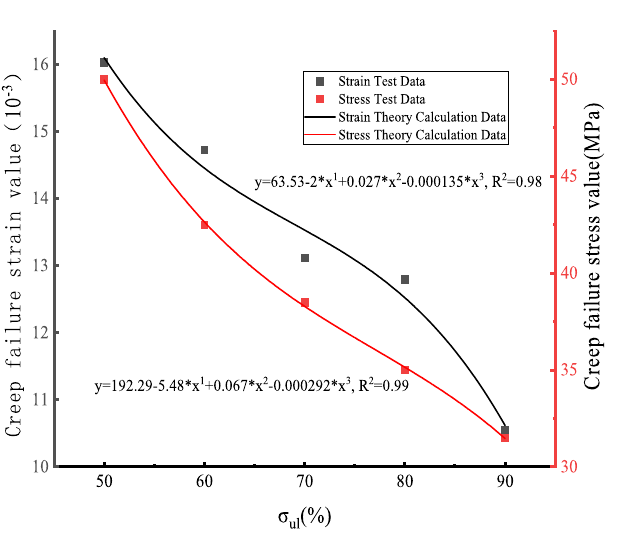
Figure 11. Creep failure stress–strain curve of white